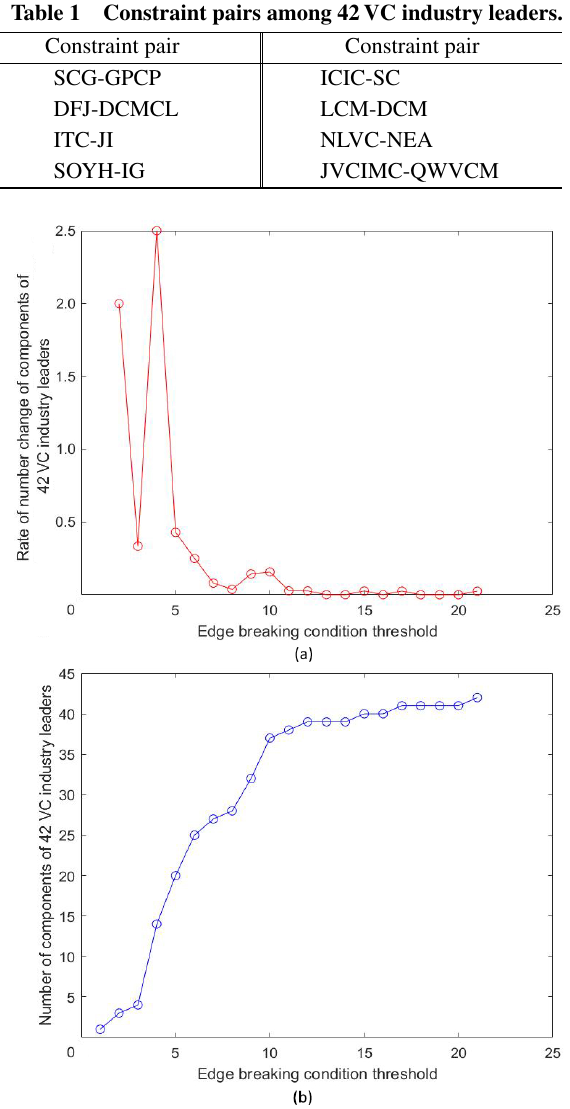
Fig. 3 Variation tendency of number of components of 42 VC industry leaders.